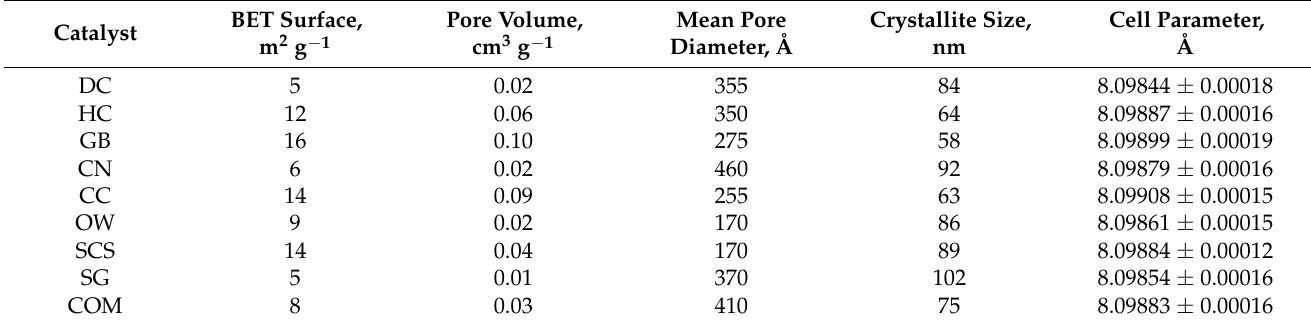
Table 1. Textural and structural properties of the bulk Co 3 O 4